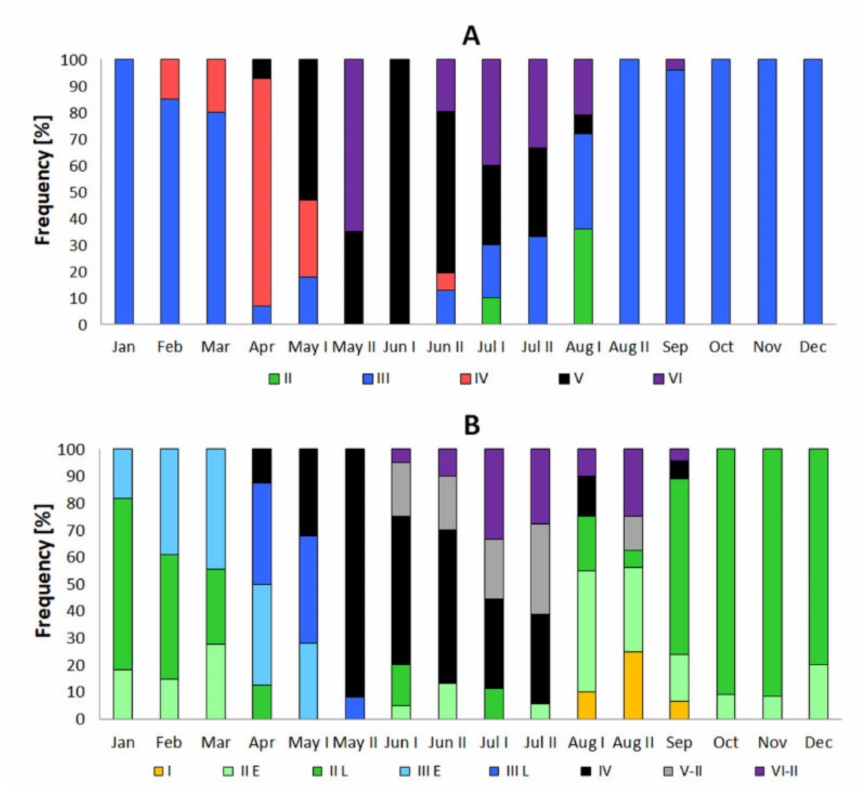
Figure 5. Frequency of gonad stage in stone moroko Pseudorasbora parva female ( A ) and male ( B ) inhabiting the Wardynka river, Poland.